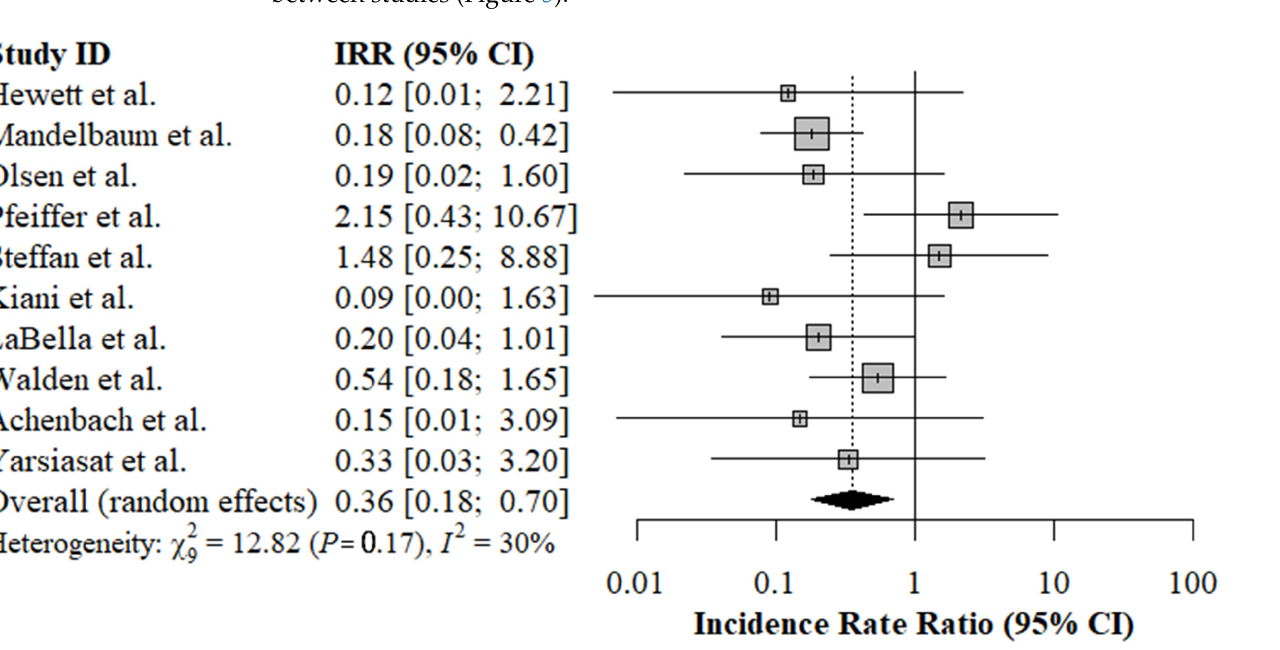
Figure 4. Main effect meta-analysis: random-effects, inverse variance weighted model. IRR: incidence rate ratio; CI: confidence interval.